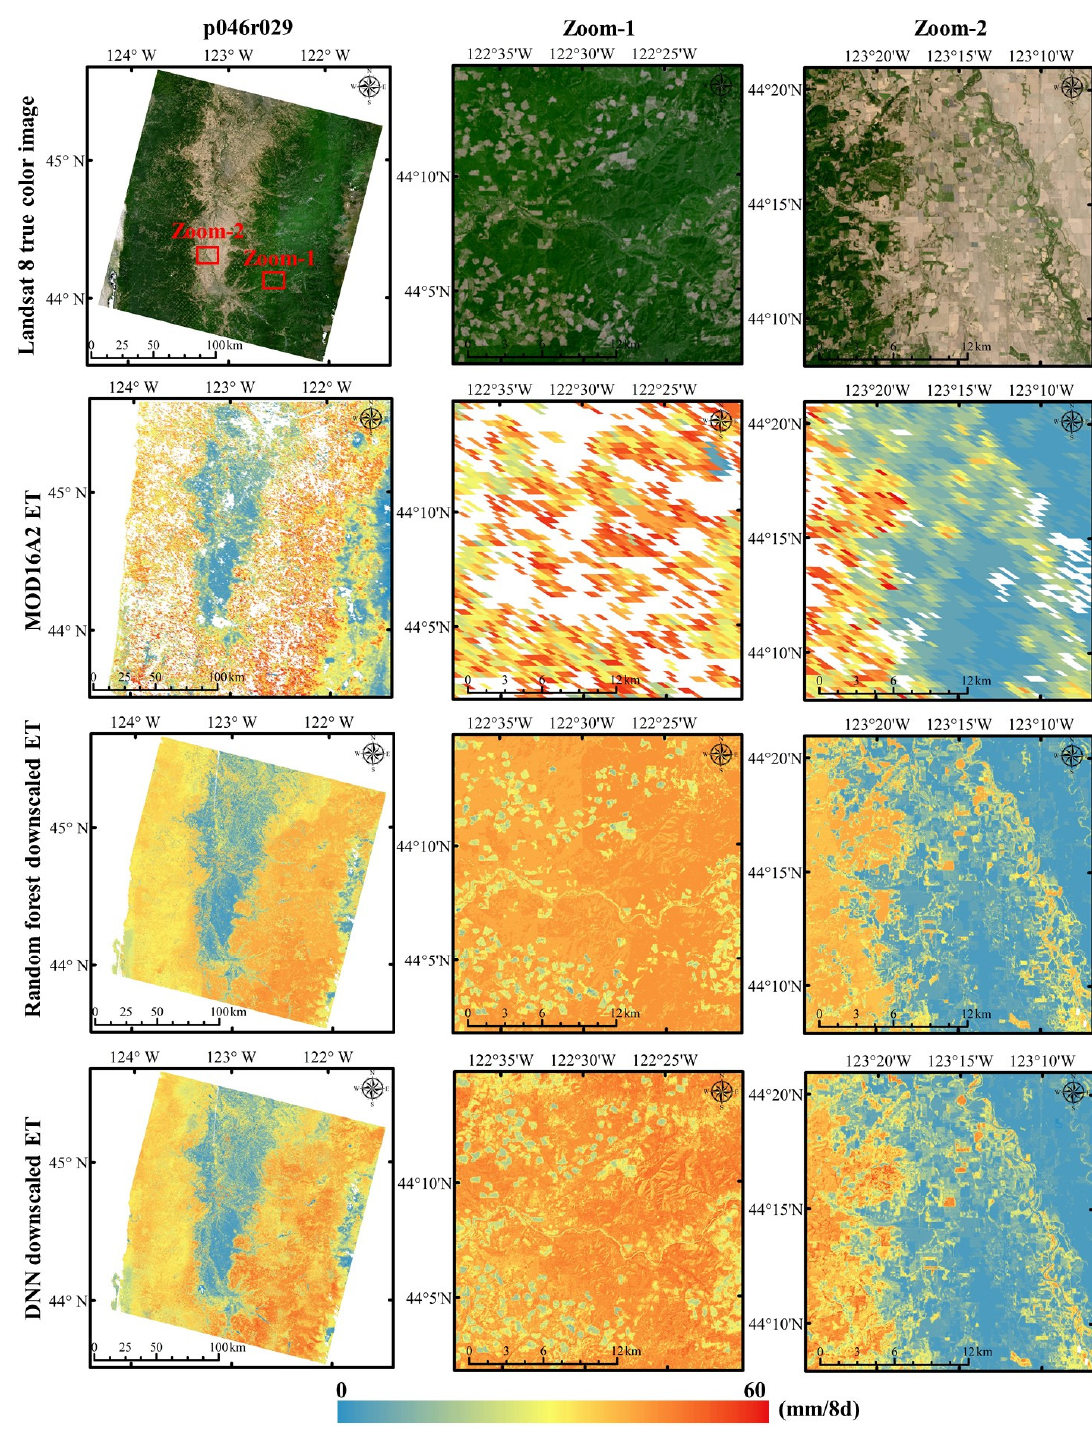
Figure 4. The p046r029 region Landsat 8 true-color SR images (first row), MOD16A2 ET (second row), random forest downscaled ET (third row) and DNN downscaled ET (fourth row). Two zoom-in areas are shown in the second and third columns. The Landsat image was acquired on 25 August 2015. The white pixels in the MOD16A2 map indicate fill values.